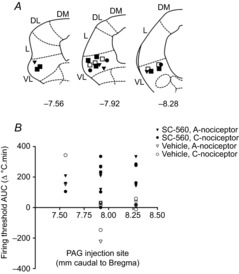
Rostrocaudal site of injection of SC-560 within the PAG does not influence the degree of inhibition of A- or C-nociceptor-evoked responsesA, injection sites within the VL-PAG: sites of SC-560 injection tested on slow ramps only (•), fast only (▾), or both (▪); vehicle sites tested on both fast and slow heat ramps (□); coordinates are relative to Bregma (DM, dorsomedial; DL, dorsolateral; L, lateral; VL, ventrolateral). B, there was no correlation between the rostrocaudal location of the injection sites within the PAG and the overall change over time (AUC) in neuronal firing thresholds to A- and C-nociceptor activation produced by intra-VL-PAG injection of SC-560 (r = 0.23, n = 19, P = 0.33; Spearman's correlation) or vehicle (r = −0.3, n = 12, P = 0.2). Note that some injection sites are overlapping.